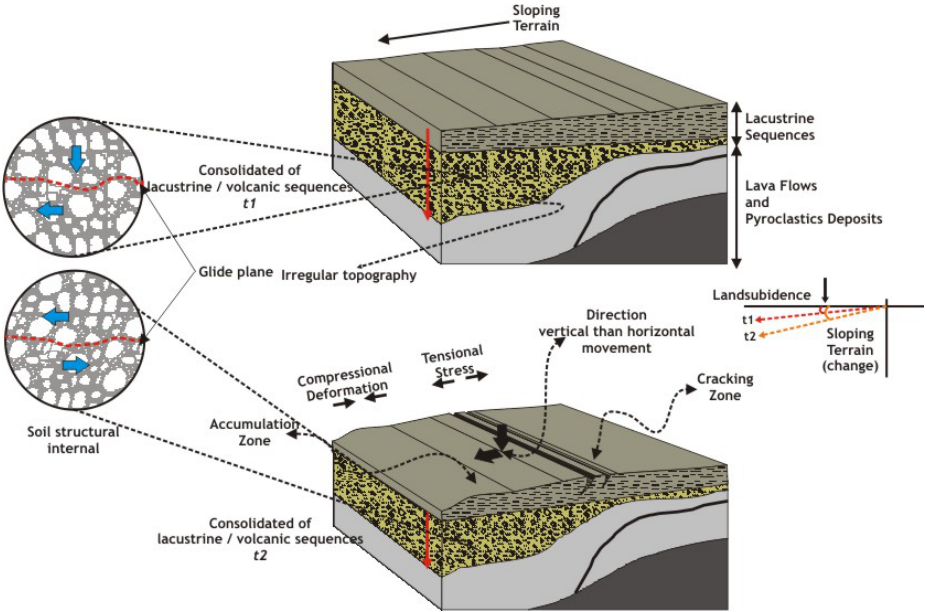
Figure 6. Conceptual model of the mass movement processes associated to land subsidence. (a) Initial conditions before consolidation of lacustrine sediments; (b) Mass movement showing the tension and compression zones in the upper and lower part of the slope respectively. Black arrows indicate the movement